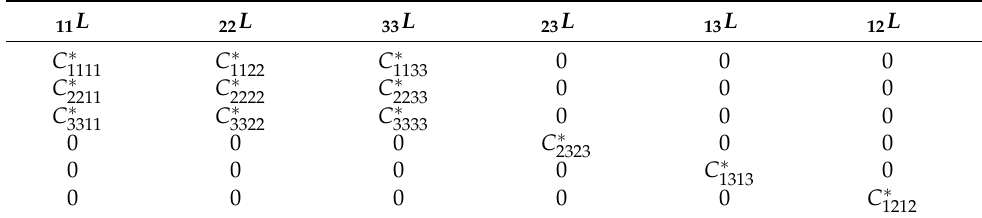
Table 1. Local problems and associated effective